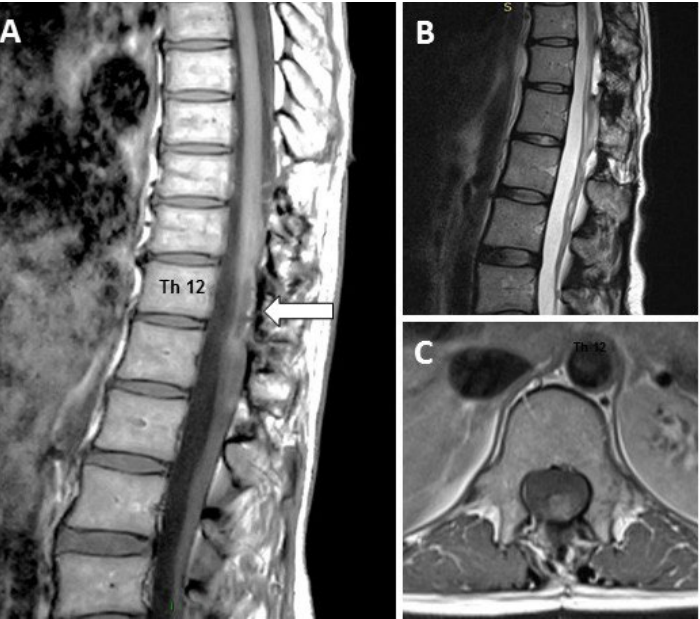
Figure 1. Magnetic resonance showing the residual lesion (arrow) due to the surgery, which occurred 10 years before cell therapy: ( A ) Sagittal T2 weighted, ( B ) Sagittal T1 weighted and ( C ) Axial T2 weighted MRI scans showing the residual spinal cord injury.